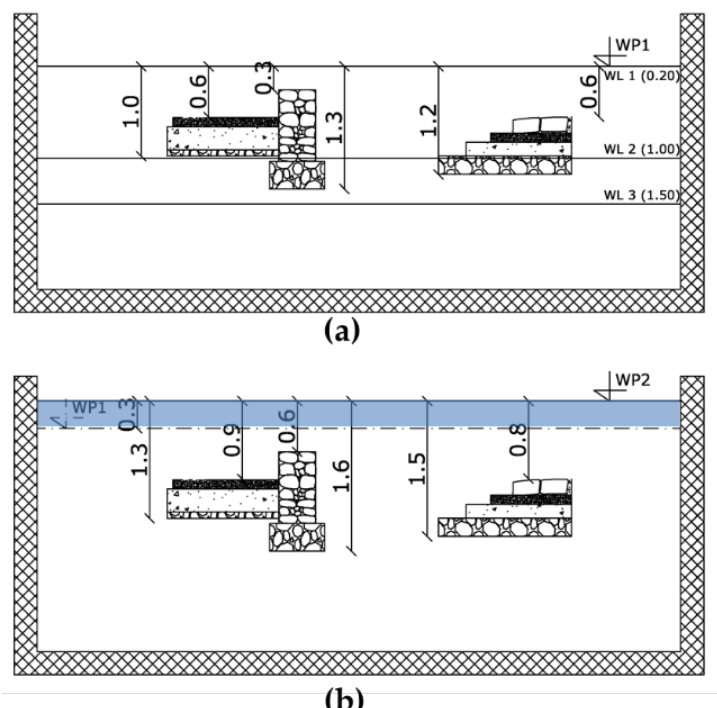
Figure 3. Two WPs were investigated: ( a ) WP1 with the water table placed at three different depths (respectively fixed to 0.20 m (WL1), 1.00 m (WL2) and 1.50 m (WL3); and ( b ) WP2, with the archaeological site covered by a water column of 0.3 m. The numbers indicate the distances in meters. (WL1), 1.00 m (WL2), and 1.50 m (WL3) from the surface of investigation (Figure 3a),